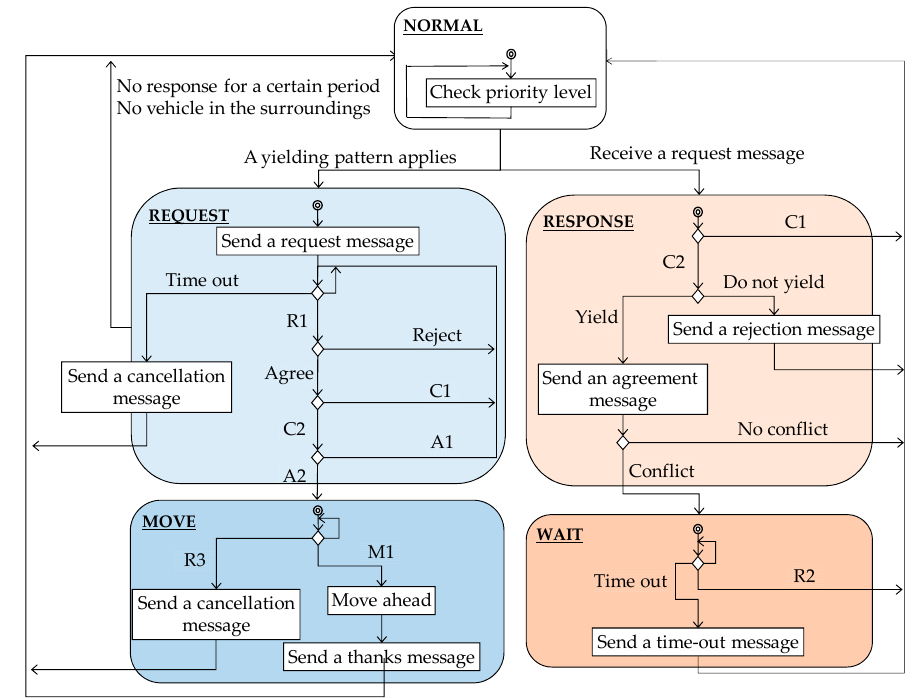
Figure 5. State transition diagram for the yielding algorithms. R1: Receive the message; R2: Receive a